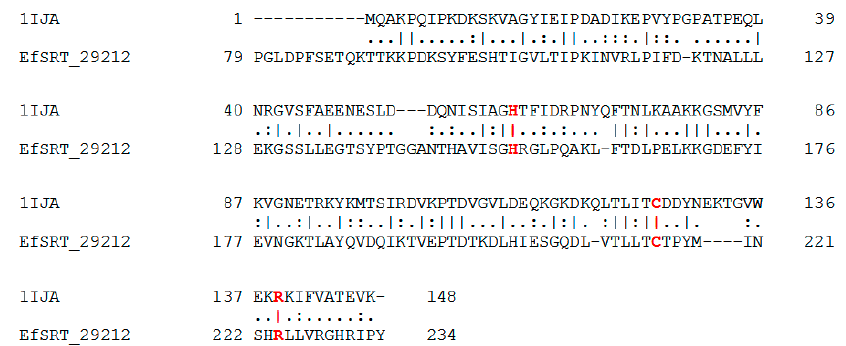
Figure 5. Sequence alignment of the E. feacalis Sortase A (EfSRT_29212) and the S. aureus Sortase A (PDB 1IJA). The catalytic amino acid residues are depicted in red.